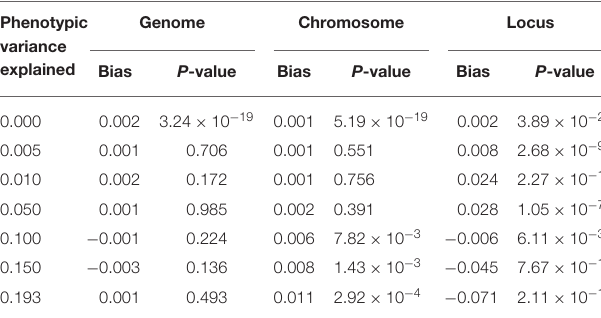
TABLE 2 | Bias in genome partitioning using